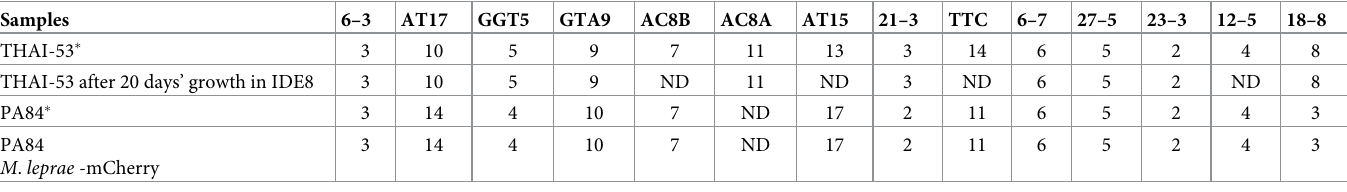
Table 2. VNTR genotypes of M . leprae samples analyzed before (original samples) and after cultivation in the tick cell line IDE8 (Thai-53 strain) and in vitro trans- formation (PA84 strain). Samples THAI-53 � THAI-53 after 20 days’ growth in